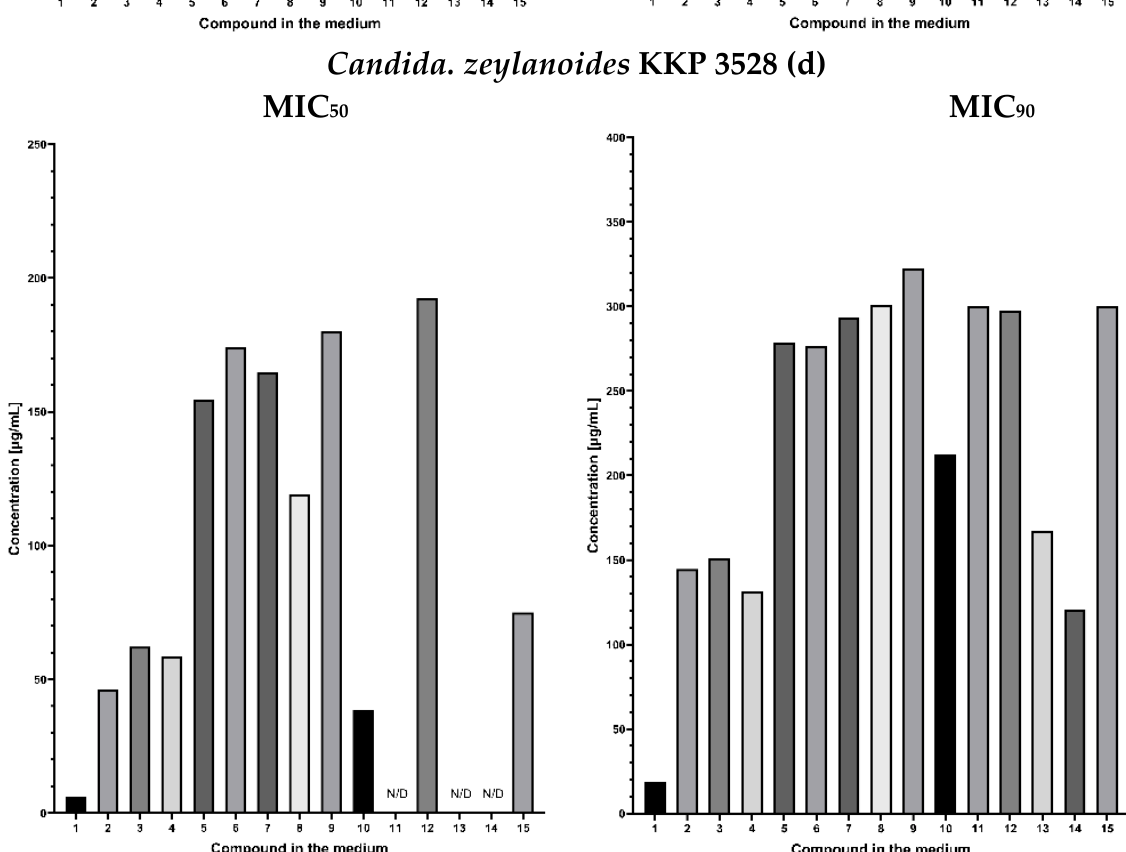
Figure 13. Experimentally determined fungistatic activity of fluconazole and lactones 2–4 and flu- conazole analogues 5–15 derivative against Candida albicans ATCC 10231, C. albicans ATCC 2091, C. zeylanoides KKP 3528, and C. guilliermondii KKP 3390 ( a – e ). MIC values are in µg/mL. MIC 50 : the amount of fungistatic substance (in µg/mL) inhibiting yeast growth by 50%. MIC 90 : the amount of fungistatic substance (in µg/mL) inhibiting yeast growth by 90%. In vitro antifungal evaluation showed that phthalide lactones had lower fungistatic activity than fluconazole (Figure 13). In the case of phthalide lactones, a 50% inhibition of the growth of microorganisms was observed at concentrations in the range 30.79–85.04 µg/mL. In the case of compound 3 , having a double bond at C-3, higher activity was ob- served against the ATCC 2091 strain, in which 17.61 µg/mL inhibited the growth of this organism by 50%. A similar situation was observed in the KKP 3390 strain, where the concentration needed to achieve a 50% growth reduction was around 36.96 µg/mL.